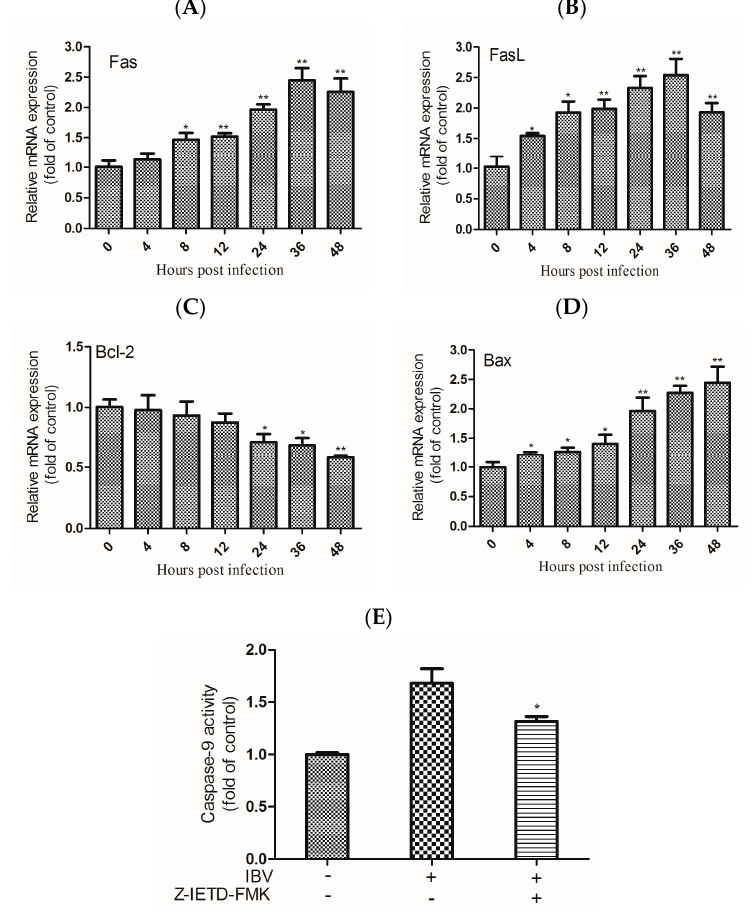
Figure 4. IBV Beaudette-induced apoptosis was regulated by the expression of Fas/Fas ligand (FasL) and the Bcl-2 family. ( A , B ) mRNA expression levels of Fas and FasL were detected in IBV Beaudette-infected cells for the indicated times. The data are shown as the mean ± SEM. * p < 0.05, ** p < 0.01 versus control. ( C , D ) mRNA expression levels of Bcl-2 and Bax were detected in IBV Beaudette-infected cells for indicated times. The data are shown as the mean ± SEM. * p < 0.05, ** p < 0.01 versus control. ( E ) The activity of caspase-9 was party blocked by caspase-8 inhibitor. Following incubation with Z-IETD-FMK for 2 h, the cells were infected with IBV Beaudette for 24 h. Caspase-9 activity was detected using a colorimetric assay kit. Data are shown as the mean ± SEM. * p < 0.05 versus virus infection alone.